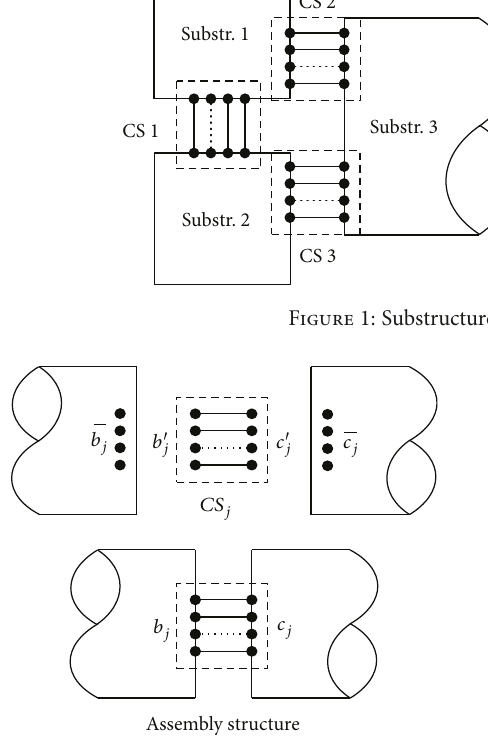
Figure 2: Connection substructure between two substructures.